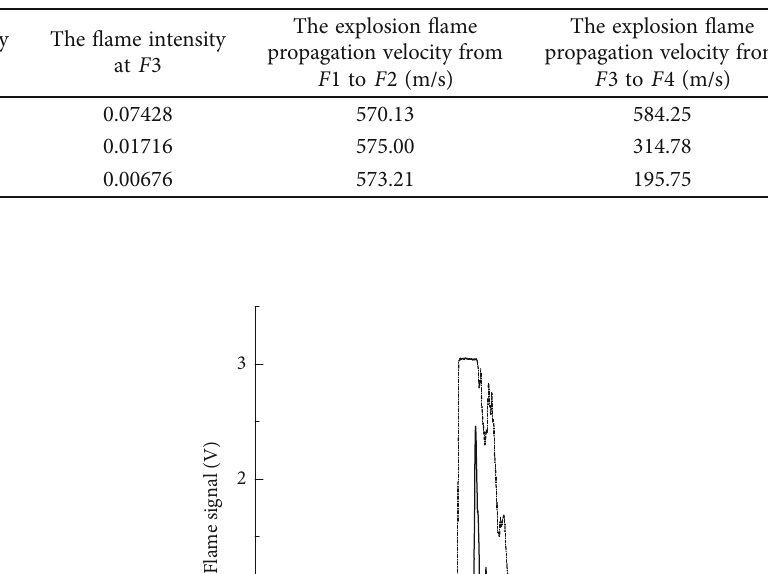
Table 2: The results in the experiments.